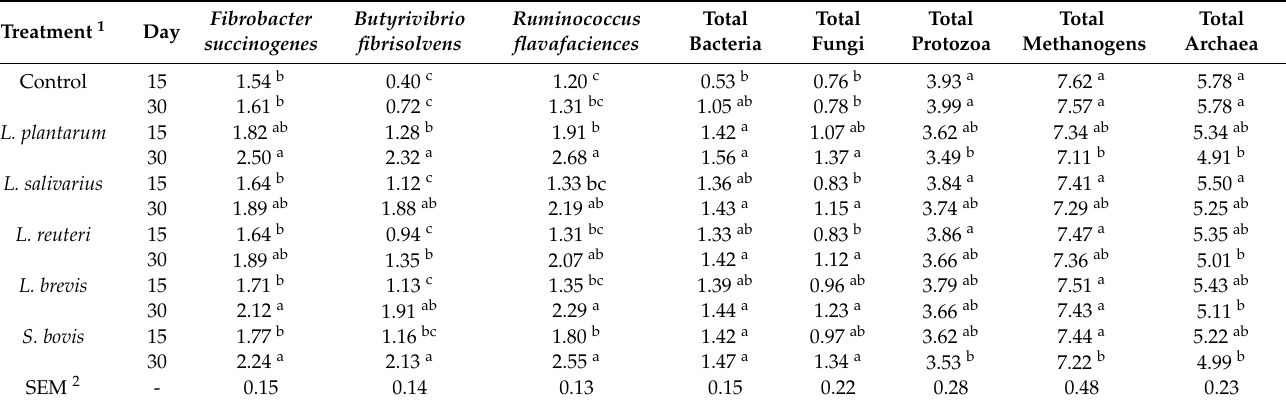
Table 6. Effects of inoculation of LAB on in vitro rumen microbial